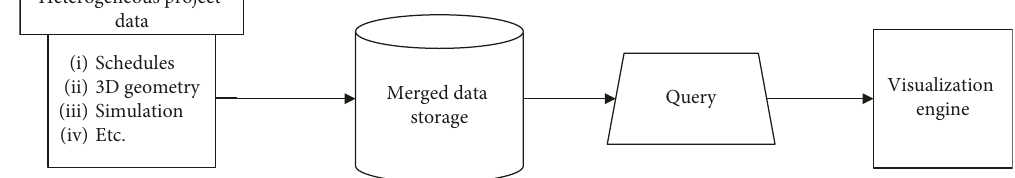
Figure 3: An overview of the proposed framework.